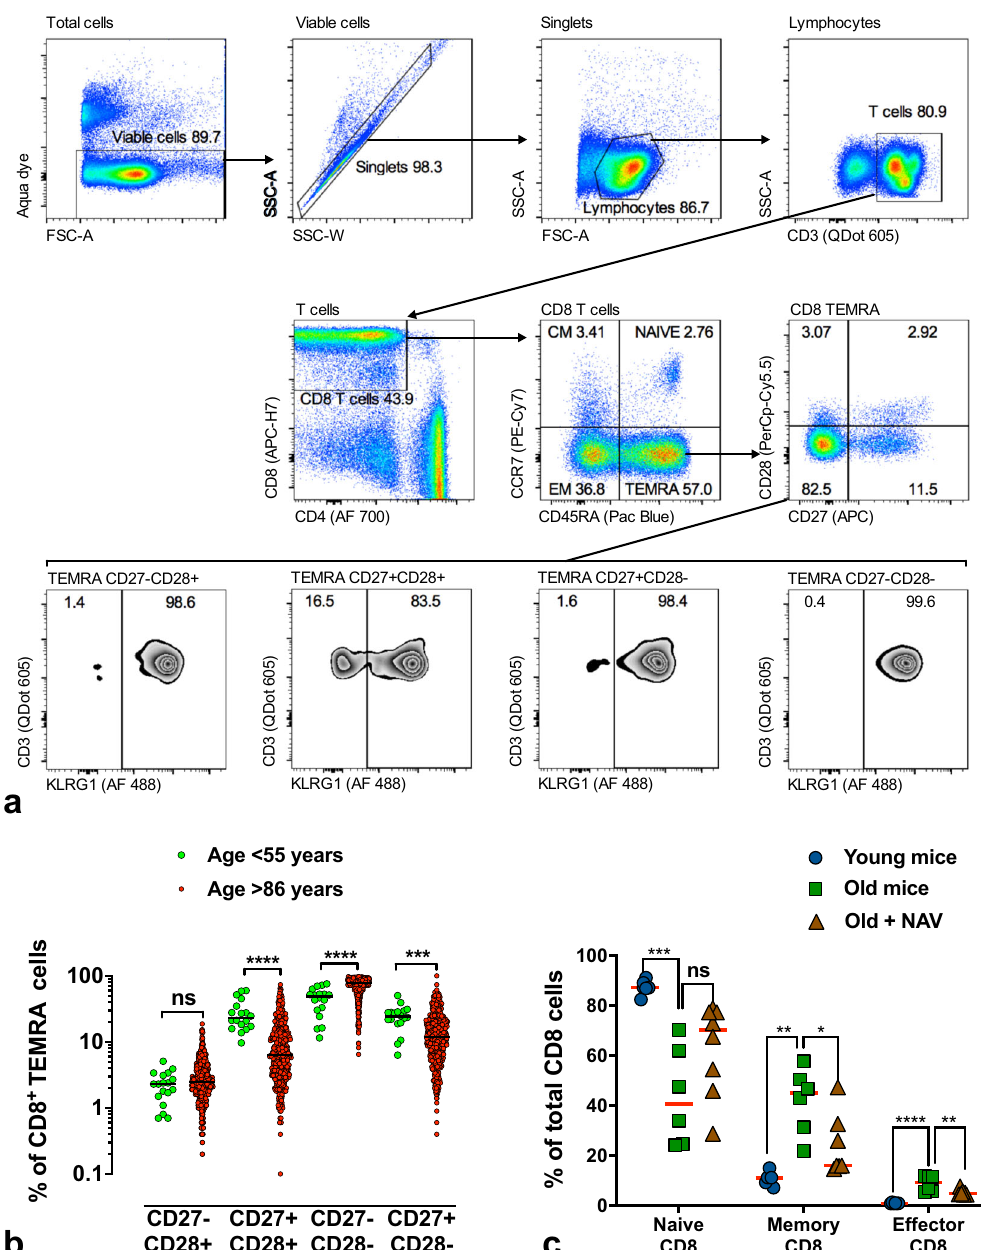
Fig. 2 Loss of naïve CD8 T-cells with increased age in men and mice. a Gating strategy for CD8 T EMRA subsets shows viable cells, singlets and lymphocyte gates, followed by T-cells (top row), CD8 + T-cells and further classi fi cation into naïve, CM, EM and T EMRA CD8 + cells depending on their CCR7 and CD45 RA expression (middle row). The latter are then plotted against CD27 and CD28 co-receptors (middle row), and KLRG1 expression is depicted for each of the four CD27/CD28 subsets (lower row). b Distribution of CD8 T EMRA subsets according to CD27 and CD28 co-receptors (healthy young control group ( n = 18) vs. 85 + study population ( n = 565). Loss of CD27/CD28 double positive cells with higher age. c Percentage of T-cell subsets from mouse splenocytes, relative to total CD8 population, in different experimental groups (young n = 6, old n = 7, and old mice treated with navitoclax n = 8). Data are depicted as single data points and mean (red line). *** p < 0.001; ** p < 0.01; * p < 0.05 using 1-way